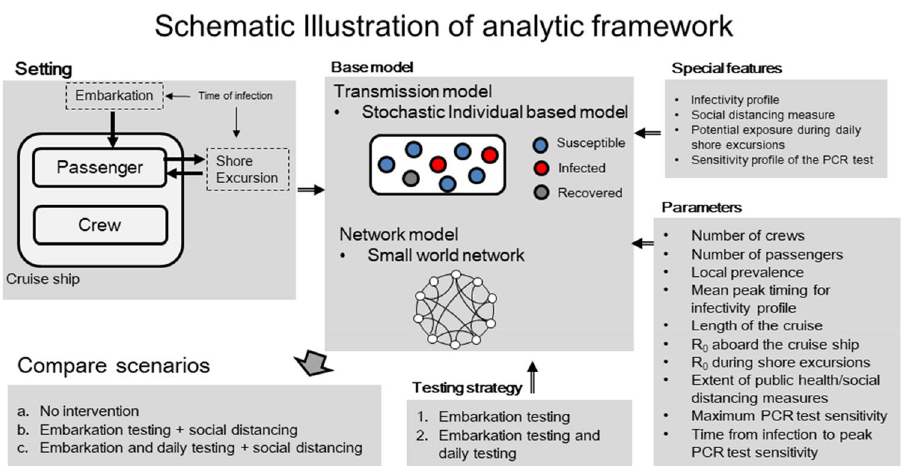
Figure 2. Schematic diagram of the individual-level stochastic model to investigate the role of testing and social distancing protocols for preventing COVID-19 outbreaks during ocean cruises. The model allows us to incorporate the role of imported cases arising during embarkation and shore excursions, our understanding of the temporal course of infectivity at the individual level as well as the effects of social distancing strategies and different testing scenarios characterized by the sensitivity profile of the test and testing frequency.